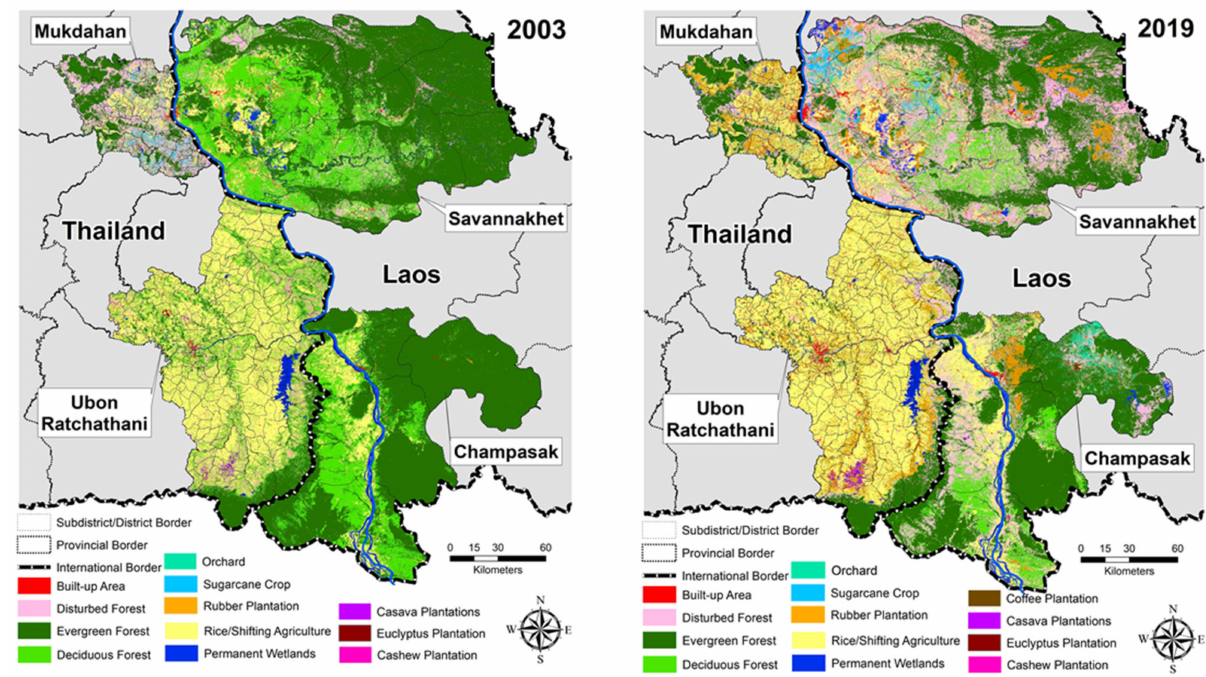
Figure 3. Land use and landcover in study provinces in Laos and Thailand from 2003 and 2019 mapped from Landsat satellite